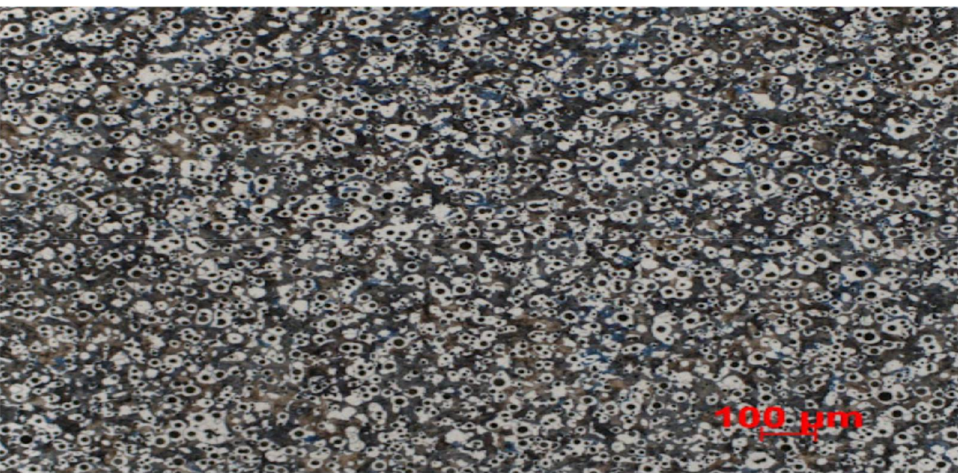
Figure 3. One of several rejected images. Comparing it with Figure 1, we can see that it would be very difficult to isolate the black structures. Source: